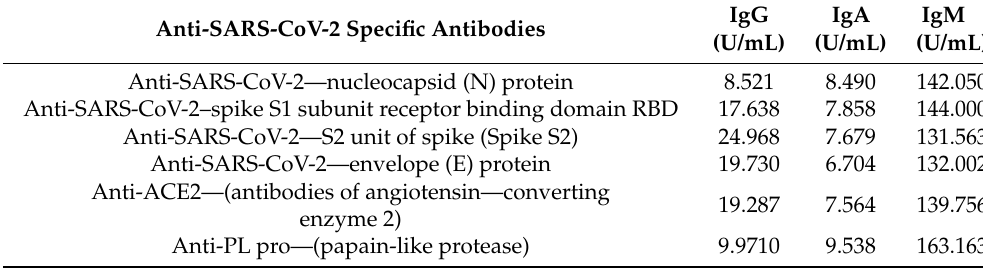
Table 1. Specific anti-SARS-CoV-2 antibodies profile 12 weeks after the debut of clinical signs. Anti-SARS-CoV-2 Specific